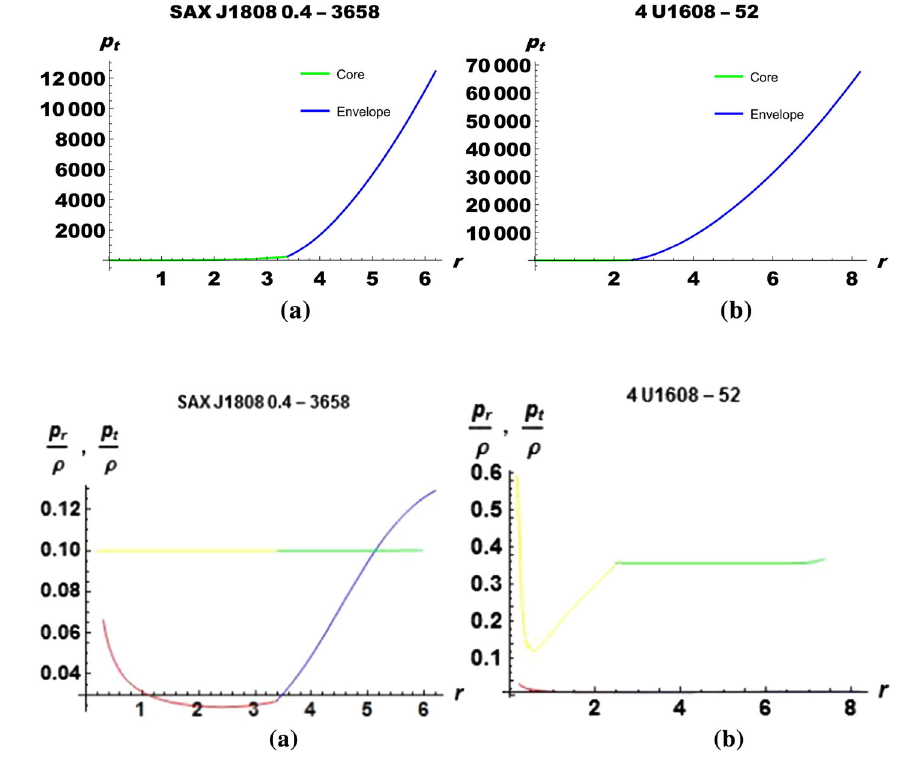
Fig. 3 Variation of tangential pressure with radial coordinate